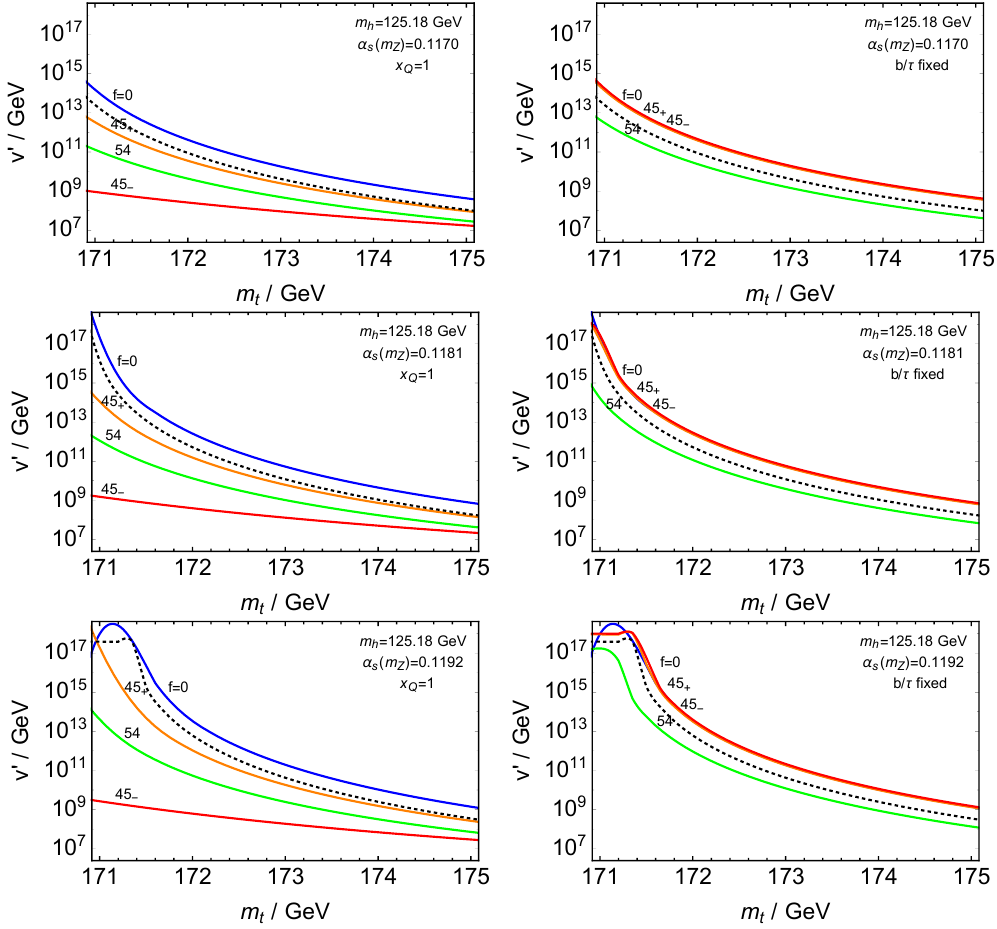
Figure 6 . The prediction of v 0 , from running of the SM quartic, as a function of m t with the three rows showing di(cid:11)erent values of (cid:11) s . Dotted lines assume (cid:21) SM ( v 0 ) = 0. Solid lines show that the dependence of v 0 on the X states of the top quark is large for x Q = 1 (left panels), but is reduced when m b =m (cid:28) is imposed (right panels), which also signi(cid:12)cantly raises the v 0 prediction. the X state for the top quark mass is a 45 or 54 , we are (cid:12)nally ready to discuss the correlation among SM parameters discussed in the